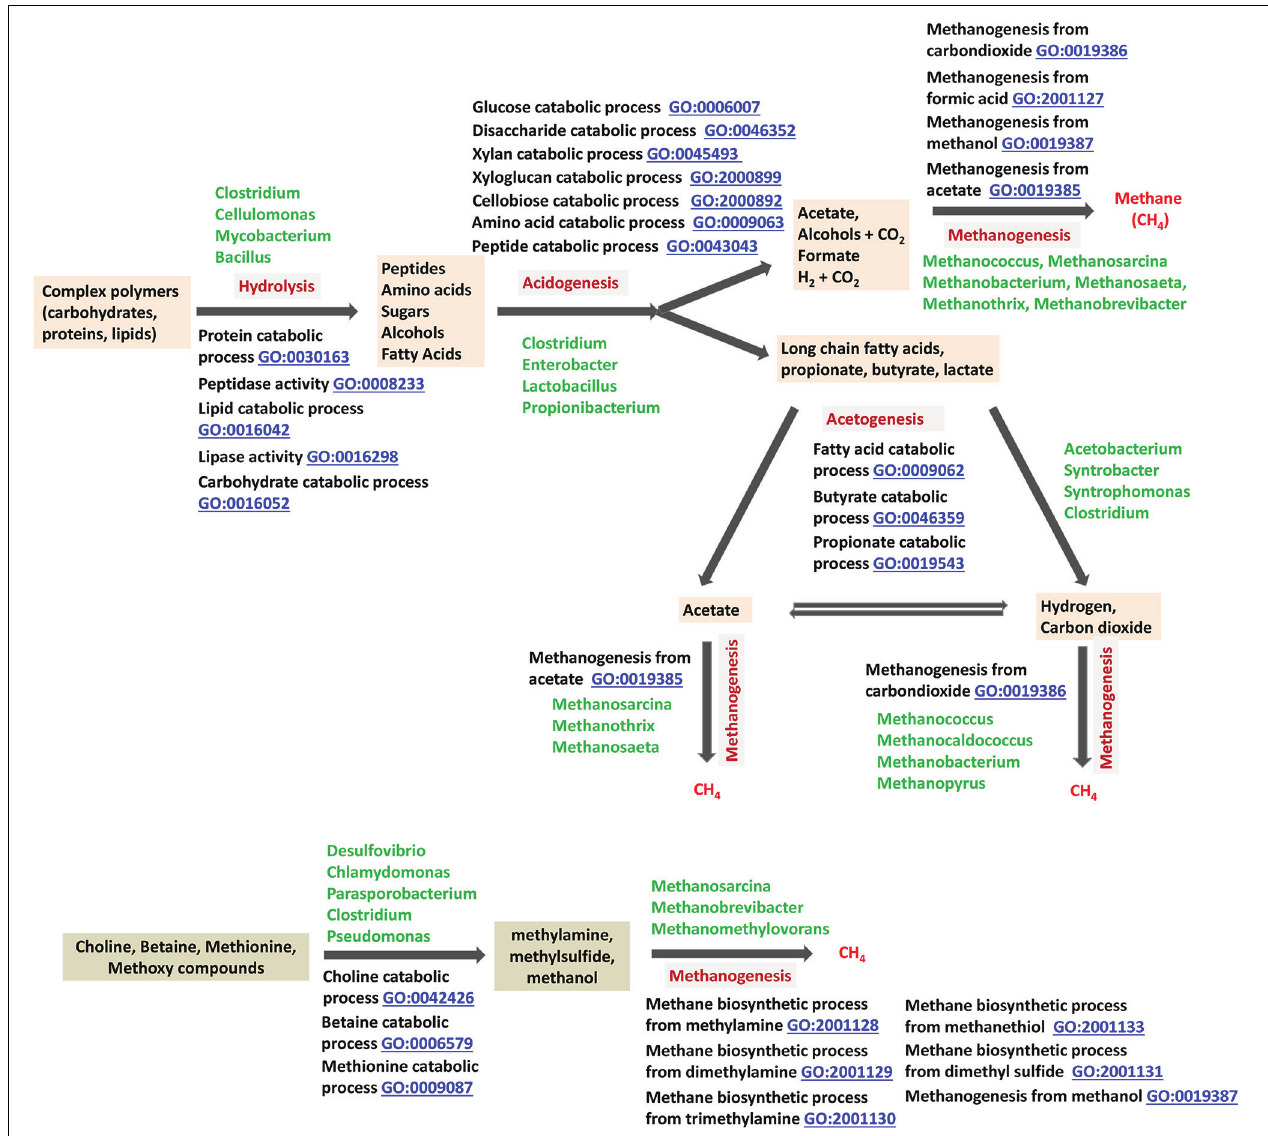
FIGURE 2 | Anaerobic digestion of complex biopolymers to methane, and relevant GO terms. The degradation of large polymers found in biomass starts with their hydrolytic fragmentation to monomers by biological hydrolysis (Zinder, 1993); in industry, chemical processes are often used for this deconstruction step (Blanch et al., 2011). Monomers are degraded further to methanogenic substrates first by acidogenic and then by acetogenic